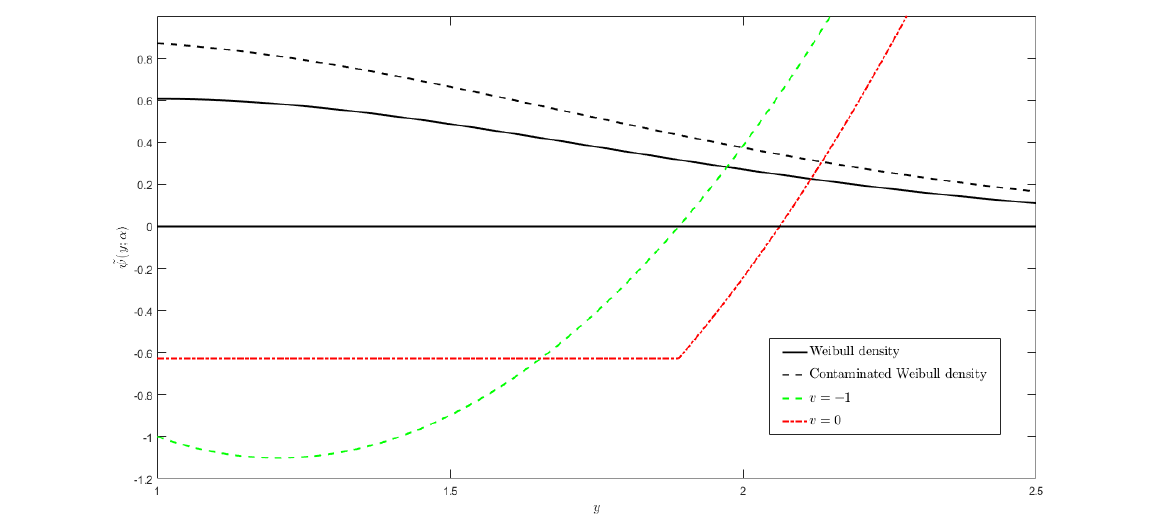
( v , ∞ ) n . Here the truncated densify functions